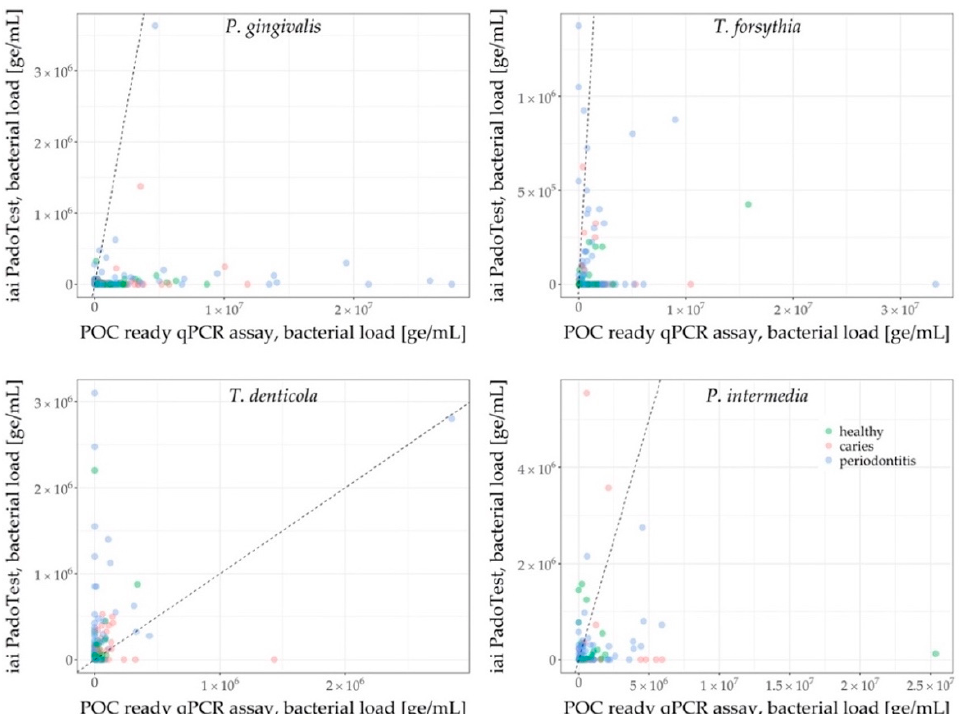
Figure 5. qPCR results for P. gingivalis , T. forsythia , T. denticola and P. intermedia. Both the iai PadoTest and the POC compatible qPCR assay results were converted into genome equivalents. Groups are color-coded (red: caries, green: healthy, blue: periodontitis). The comparison shows much higher sensitivity of the POC compatible qPCR assay in saliva, compared to the iai PadoTest for P. gingivalis and T. forsythia (and less pronounced for P. intermedia ). Only T. denticola in turn, is detected more frequently using the iai PadoTest than the POC compatible qPCR assay.